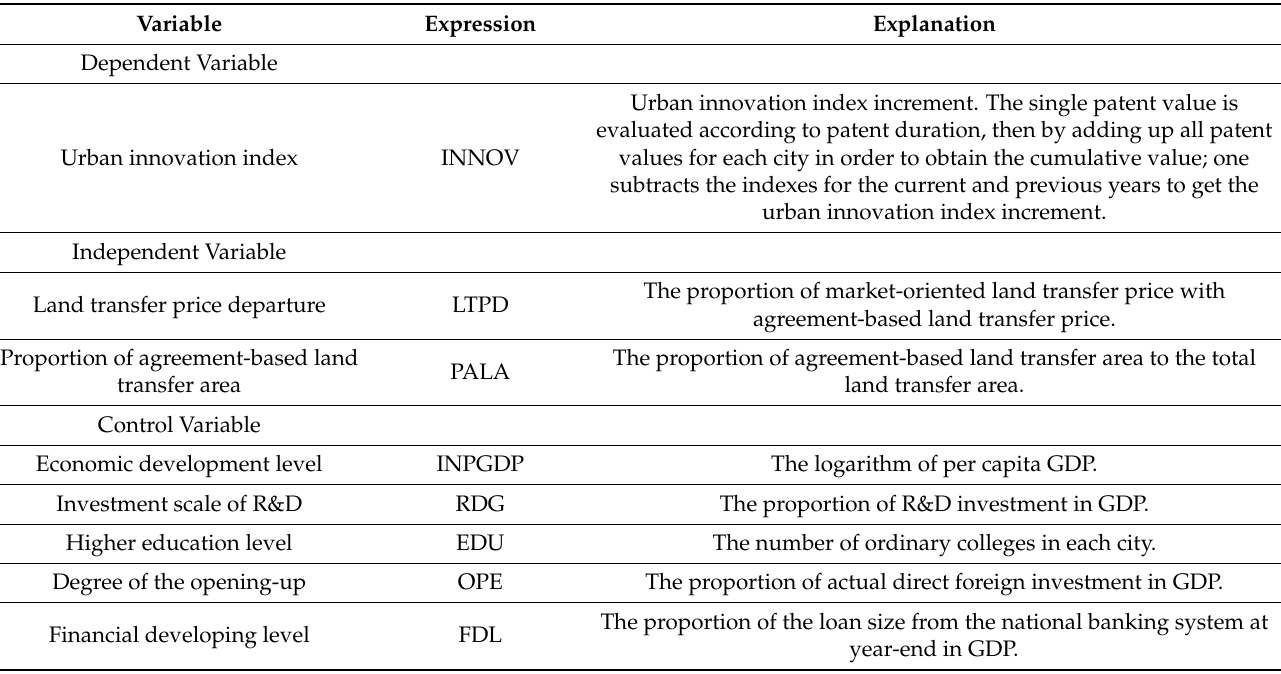
Table 1. Variable selection and